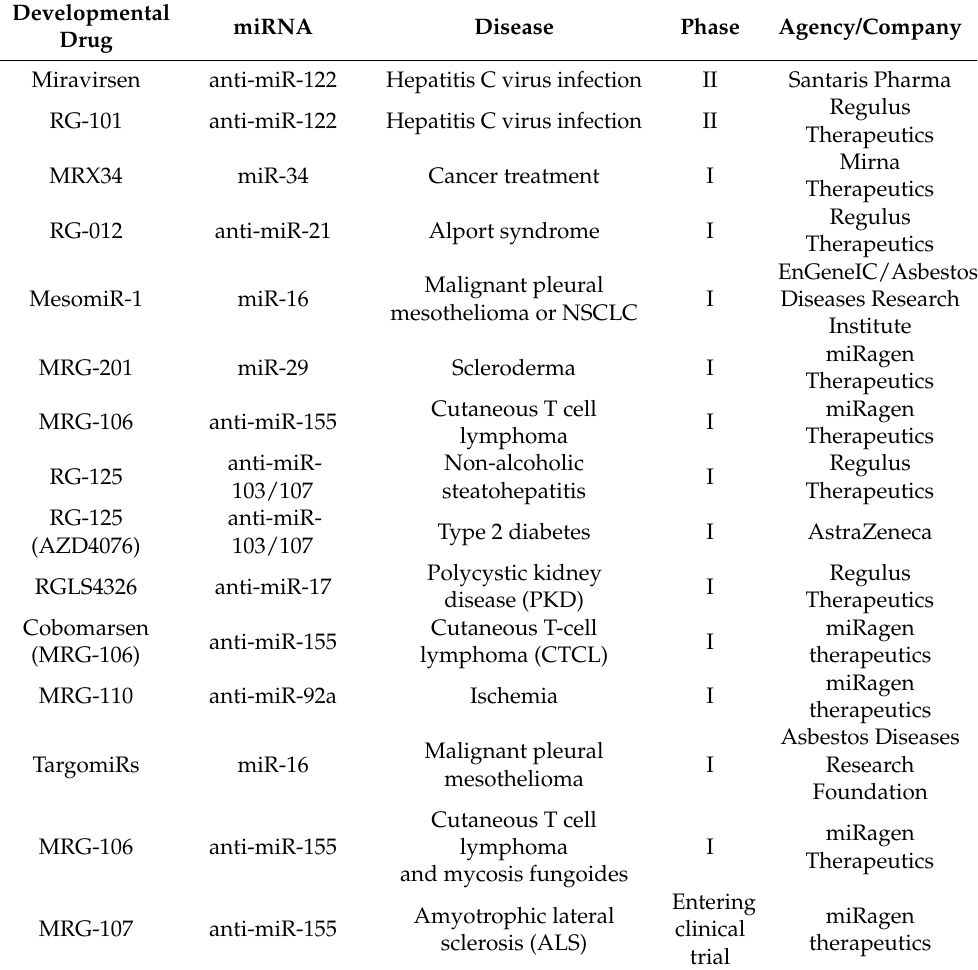
Table 2. Selected list of miRNA-based clinical